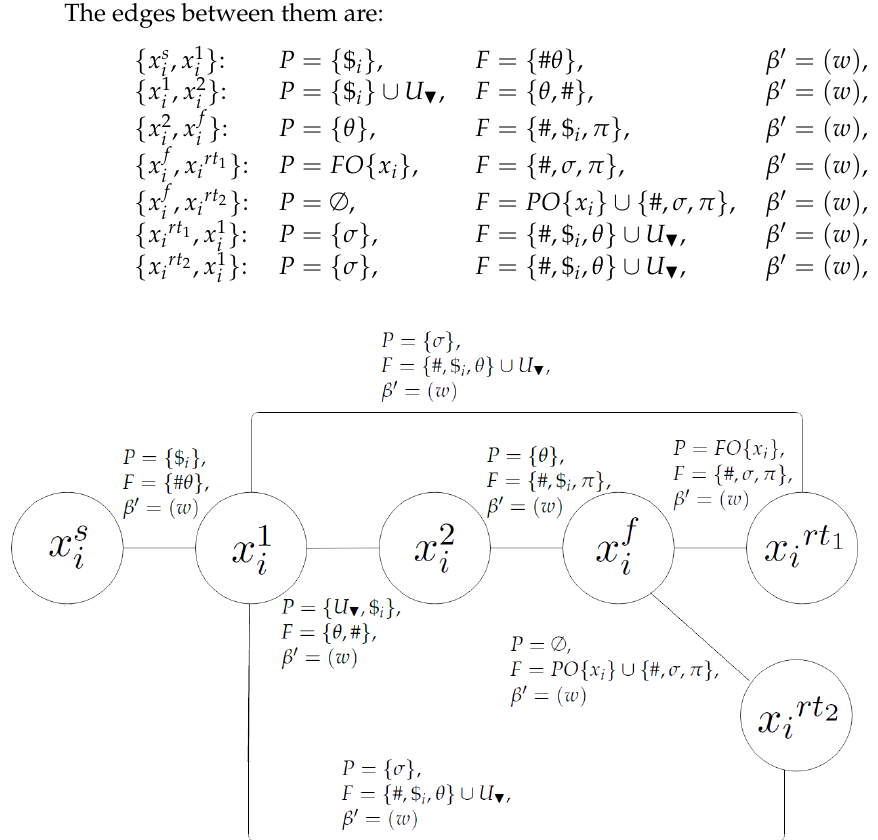
Figure 2. Subnetwork for splicing